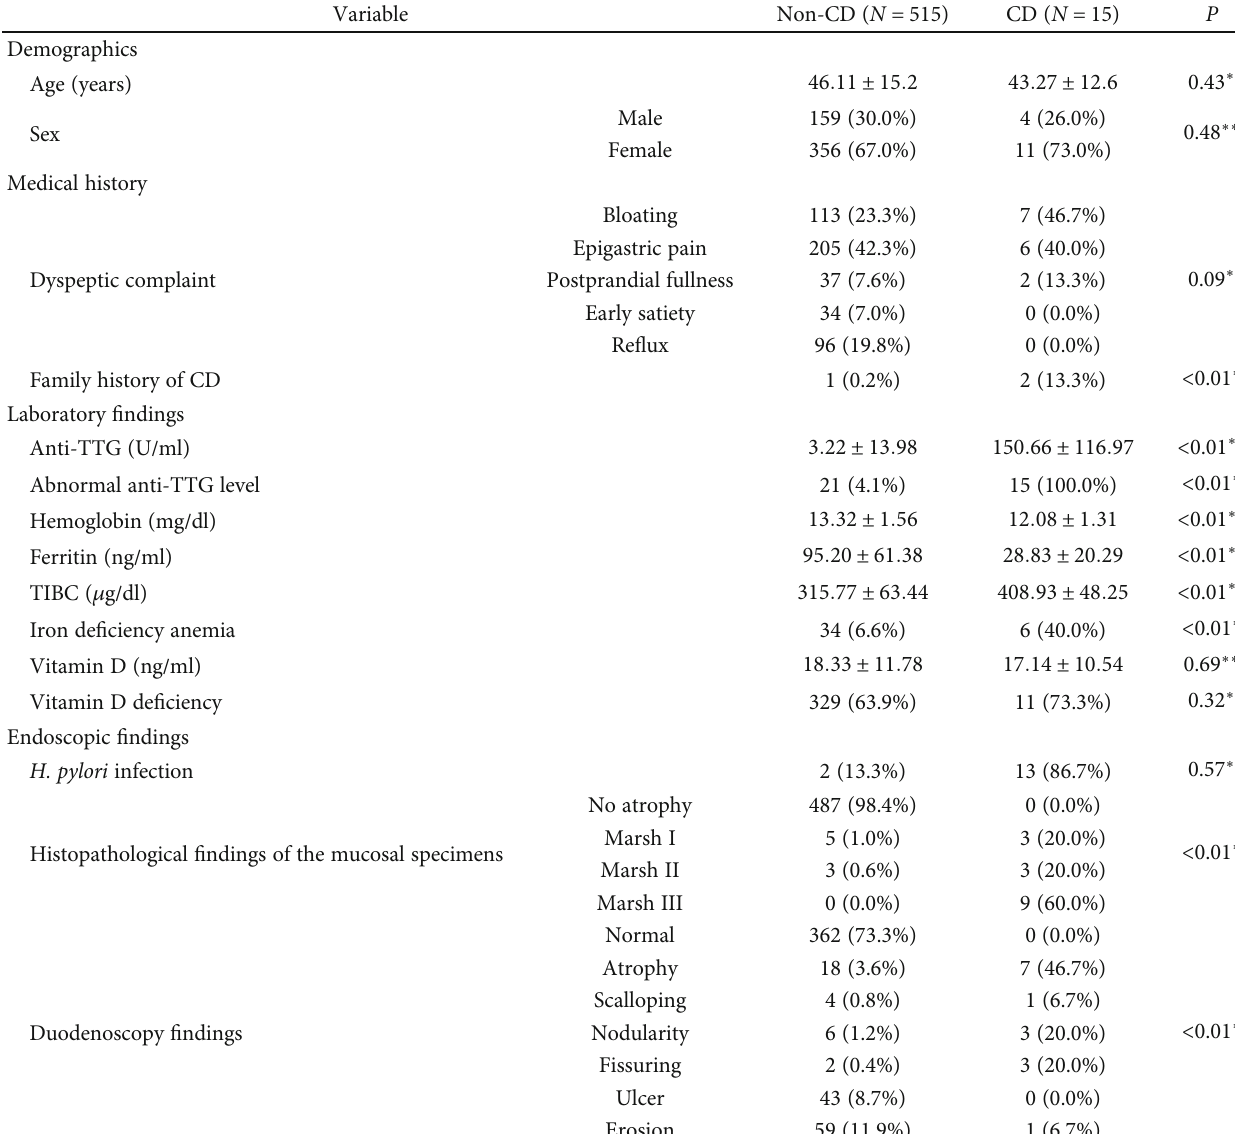
Table 1: Comparison of the characteristics of participants with and without celiac